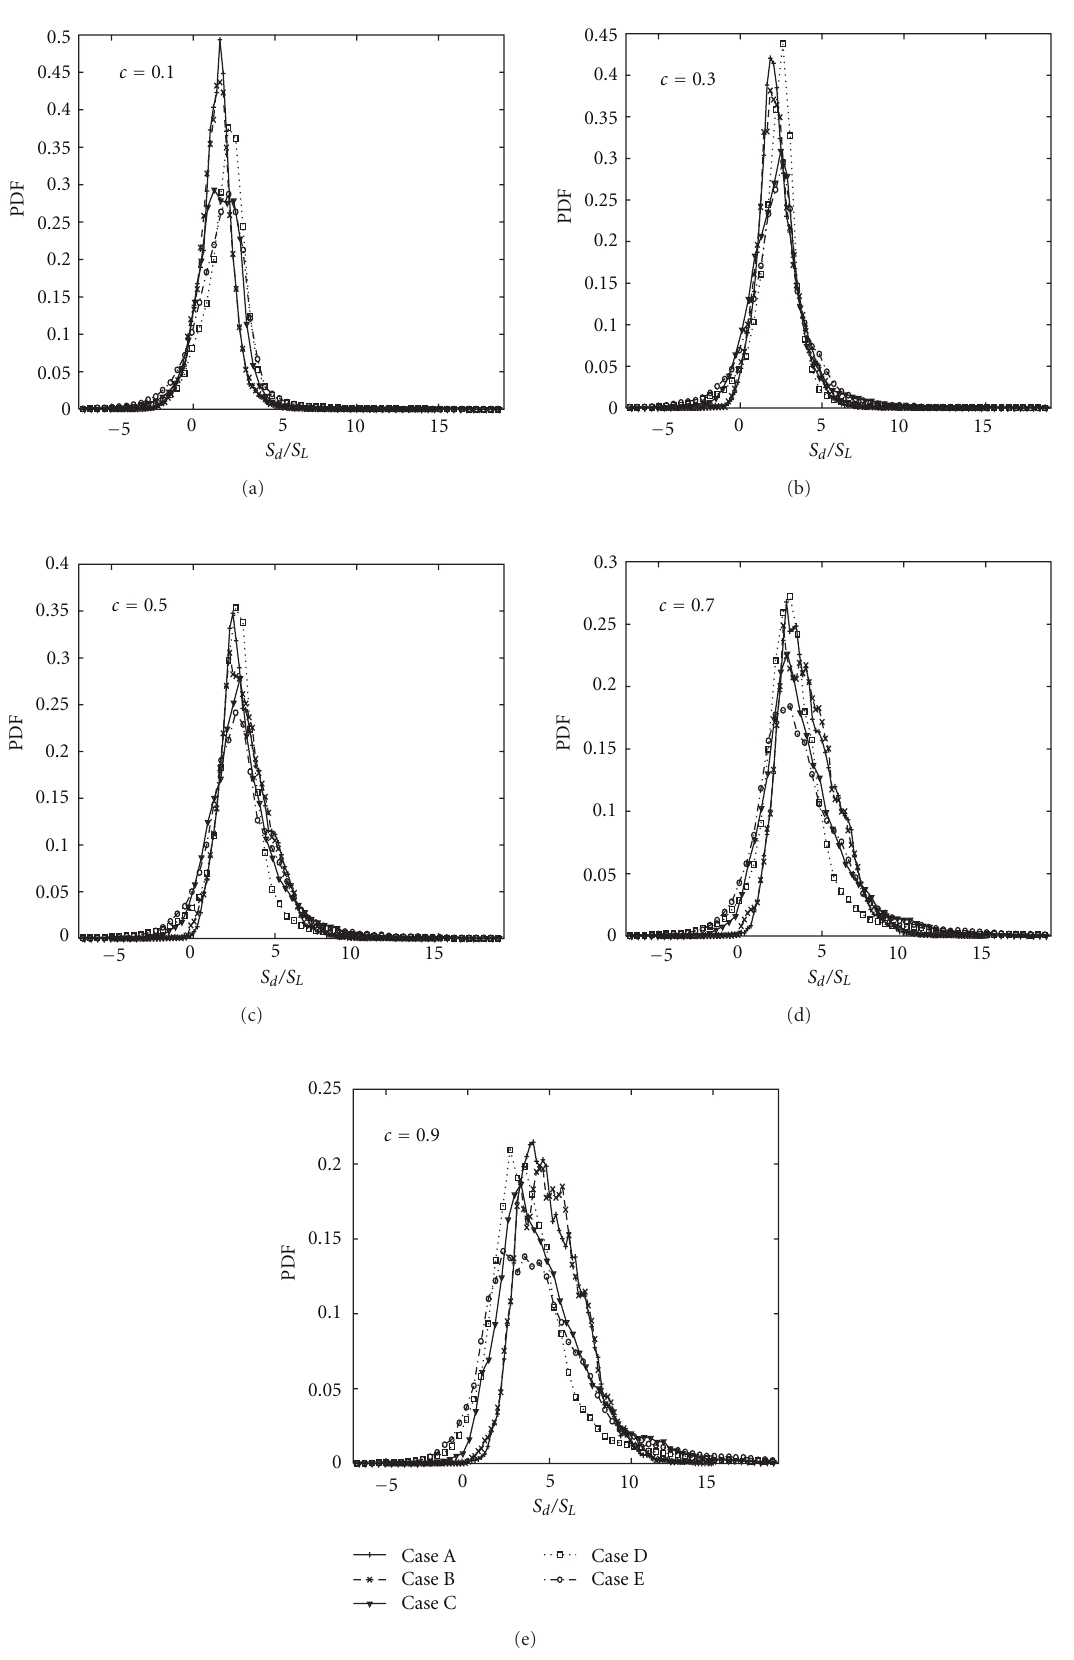
Figure 2: Pdfs of normalised displacement speed S d /S L on the c = (a) 0.1, (b) 0.3, (c) 0.5, (d) 0.7, and (e) 0.9